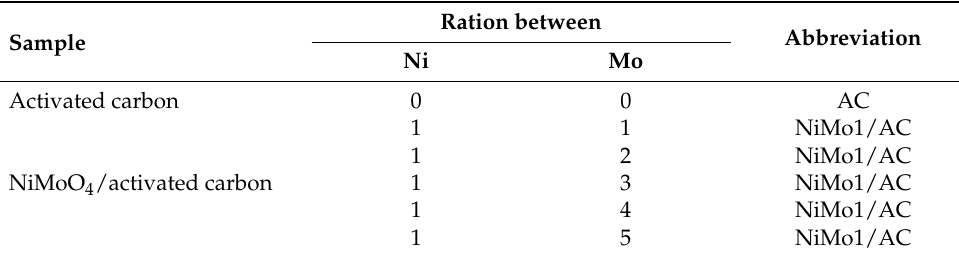
Table 1. The abbreviations for the prepared